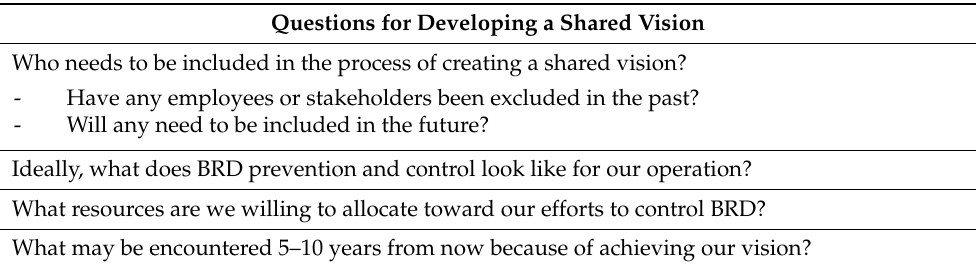
Table 2. Probing questions to consider when developing a shared vision of a desired